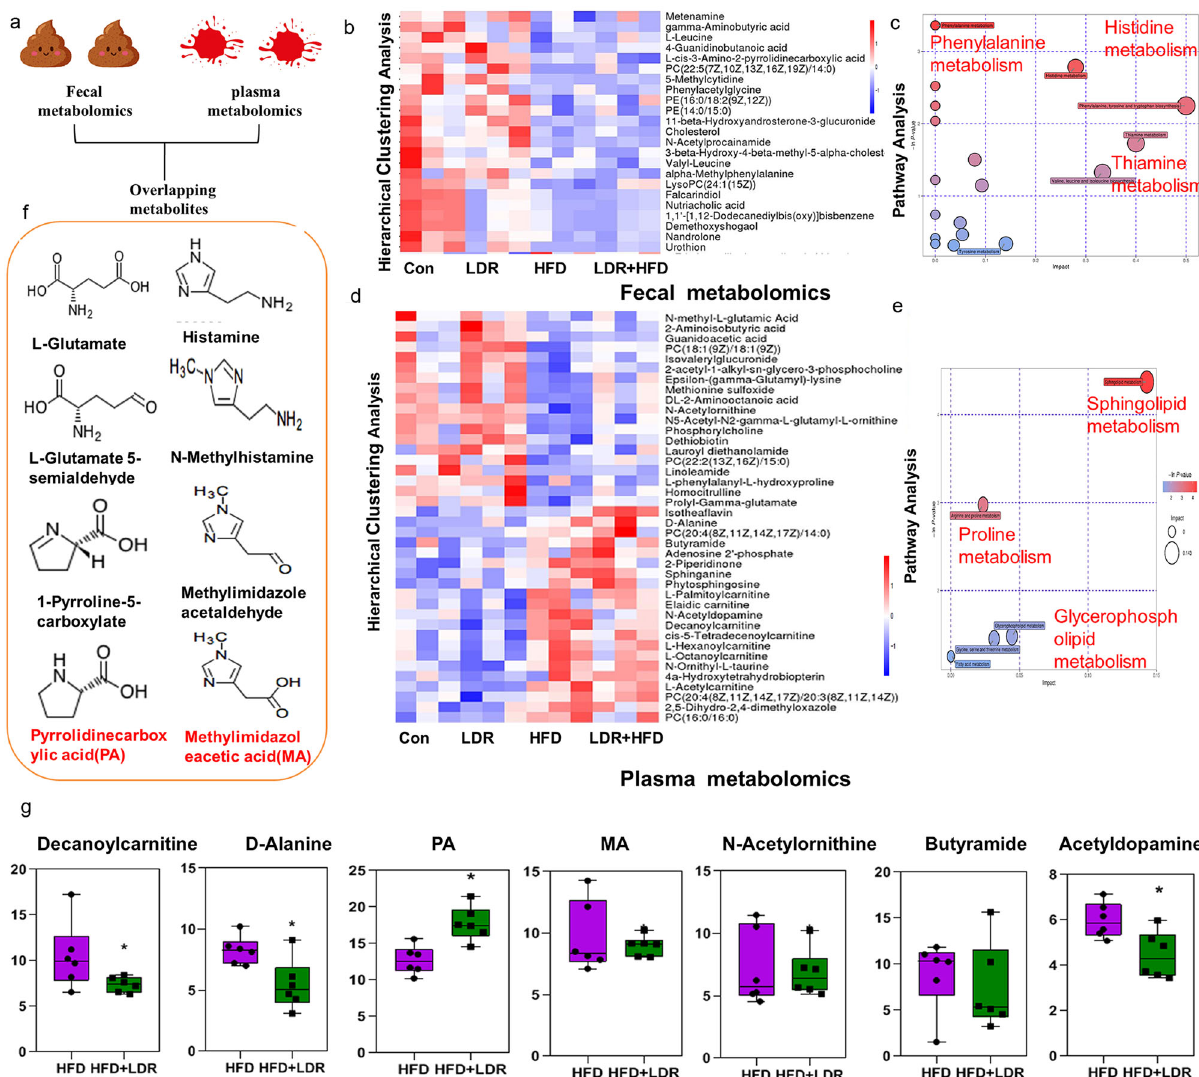
Fig. 4 Pro fi ling of faecal metabolomes and plasma metabolomes under conditions of LDR + HFD synergism. a Exploration of overlapping metabolites coexisting in both faecal metabolomes and plasma metabolomes. b Cluster heatmap showing the metabolite properties of the faecal metabolomes among the Con, LDR, HFD and LDR + HFD groups of mice. c The potential metabolic pathways for the mouse faecal metabolomes were analysed among the Con, LDR, HFD and LDR + HFD groups. d Cluster heatmap showing the metabolite properties of the plasma metabolomes among the Con, LDR, HFD and LDR + HFD groups of mice. e The potential metabolic pathways for the mouse plasma metabolomes were analysed among the Con, LDR, HFD and LDR + HFD groups of mice. f The PA and MA pathways were upregulated in the LDR + HFD group compared with the HFD group. g Differences in microbial metabolites between HFD and LDR + HFD mice (n = 6 mice per group). Microbial metabolites were up- or downregulated in the LDR + HFD group compared with the HFD group. The differences were examined by Wilcoxon rank-sum test (* p < 0.05 indicates a signi fi cant difference). The boxplot elements are de fi ned as follows: central line, median; box limits, upper and lower quartiles. Error bars indicate SEM (standard error of the mean). a was created by Ruixue Huang and the elements used was permitted by Biorender (https://biorender.com/) because Ruixue Huang is one of the registered